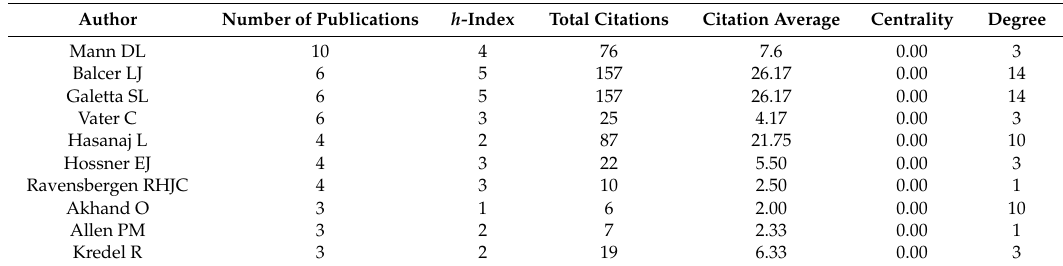
Table 4. Top 10 authors with the largest number of